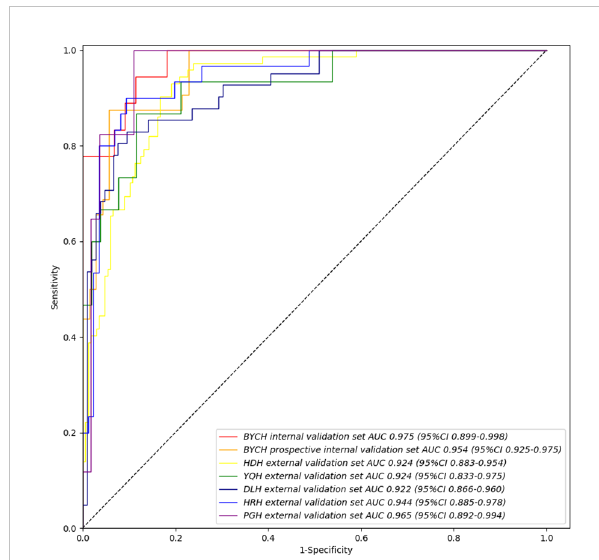
FIGURE 3 IDBCS ’ s performance on different validation datasets. The datasets contain BCYH internal validation set, BCYH prospective internal validation set, HDH external validation set, YQH external validation set, DLH external validation set, HRH external validation set, and PGH external validation set. The ROC curve and AUC were all calculated on the patient level, which has been clari fi ed in equation